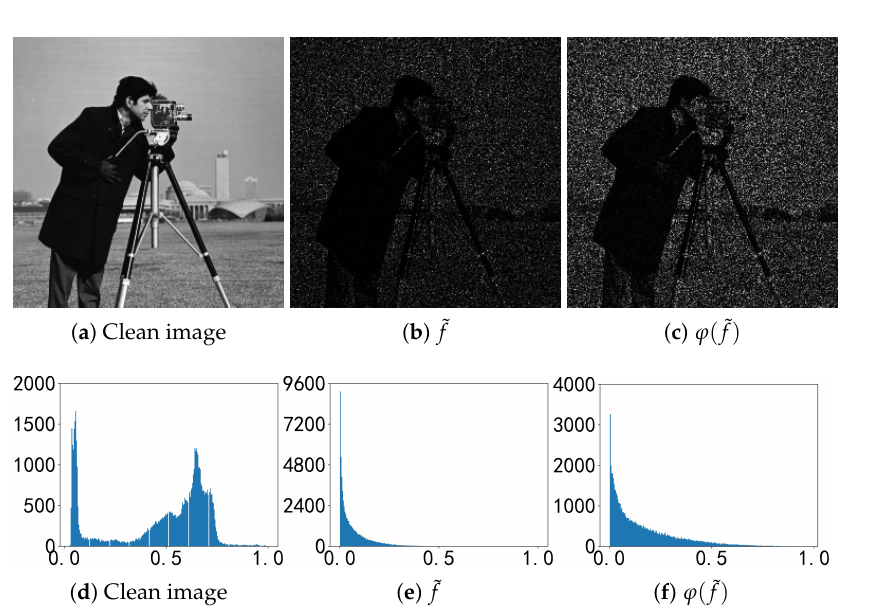
Figure 3. Histograms of the image Cameraman with noise level K =